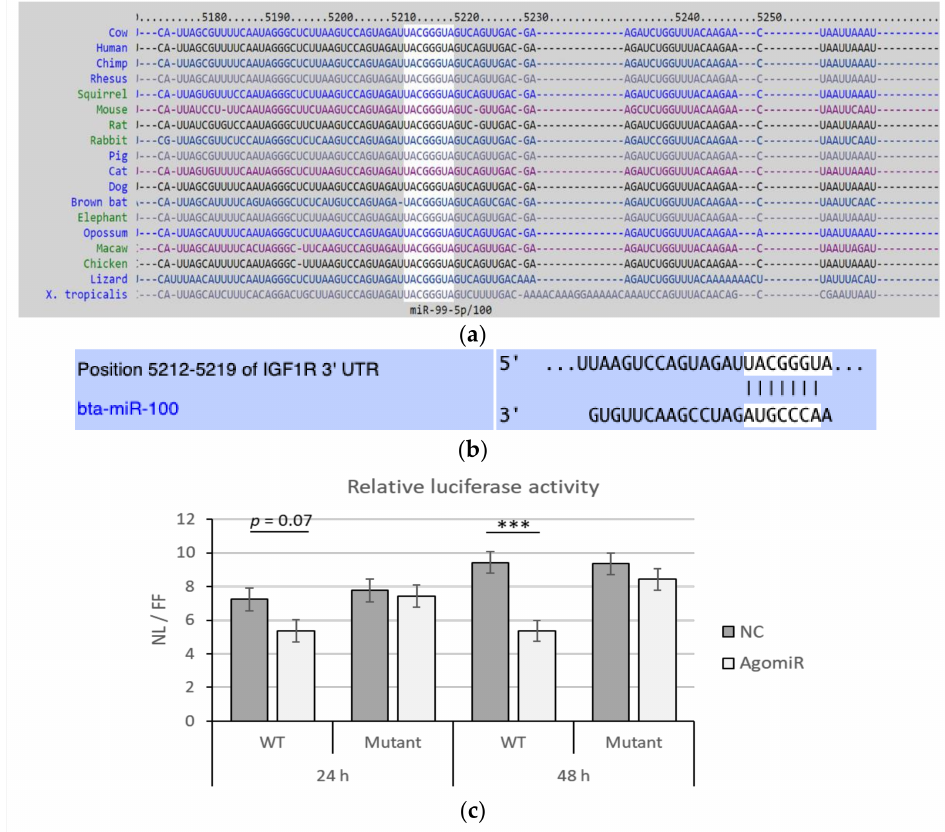
Figure 1. Functional miR-100 binding site identification and physical interaction on IGF1R 3 (cid:48) UTR. Seed-matched sequences in the IGF1R 3 (cid:48) UTR for miR-100 are conserved across species with white background in the figure, ( a ) including bovine ( b ). Dual-luciferase reporter assays determining the interaction of overexpressed miR-100 (AgomiR) and negative control (NC) with the miR-100 seed site (wildtype, WT) or its mutated version (Mutant) post 24 and 48 h of transfection ( c ). Data is representative of four independent experimental replicates per sample group. Relative expression levels (NanoLuc/Firefly-NL/FF) are presented, and if significantly different, it is indicated with *** ( p <